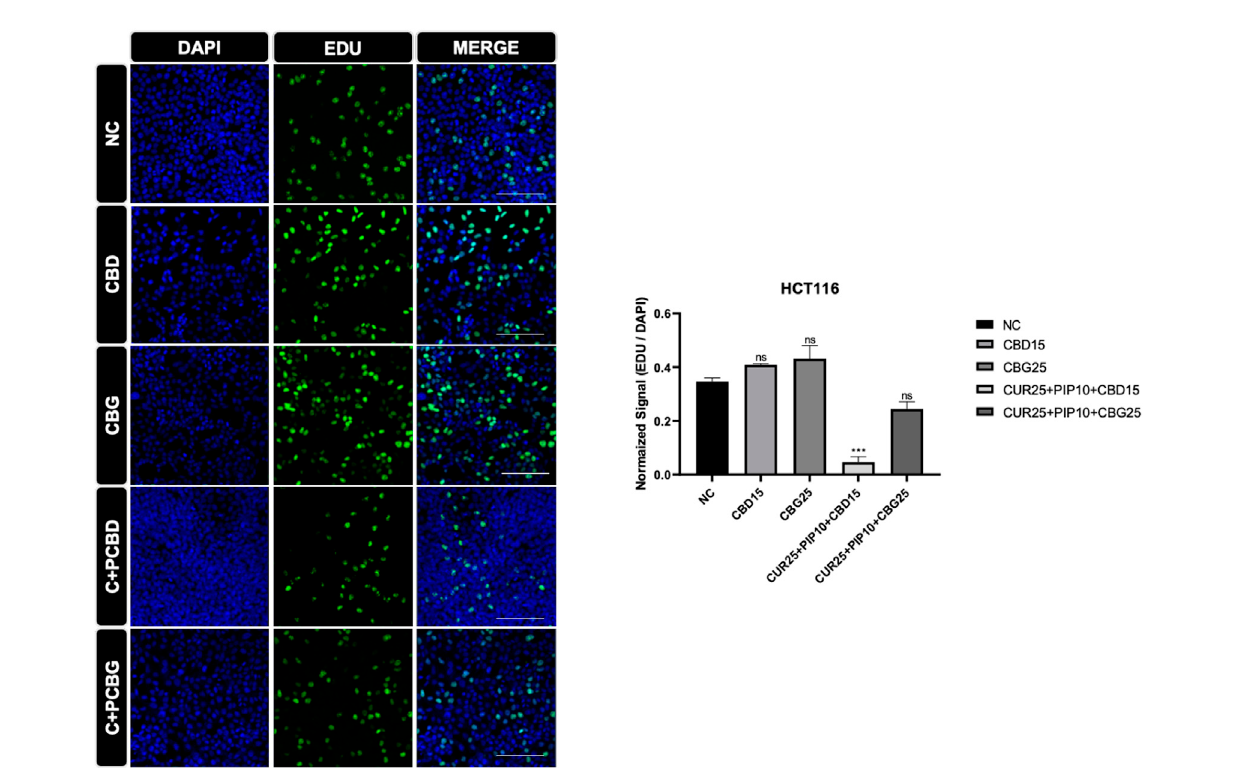
FIGURE 8 Representative results of the EDU assay are shown for HCT116 cell line. Dividing cell werelabelled with EDU (green). DAPI staining was in bluein the nucleus. Histogram graph was indicated normalizedsignaling rate ofEDU cells. (Scale baris 100 µm) (ns:non-signi fi cant, *: p < 0.05, **: p < 0.01,***: p < 0.001, ****: p <